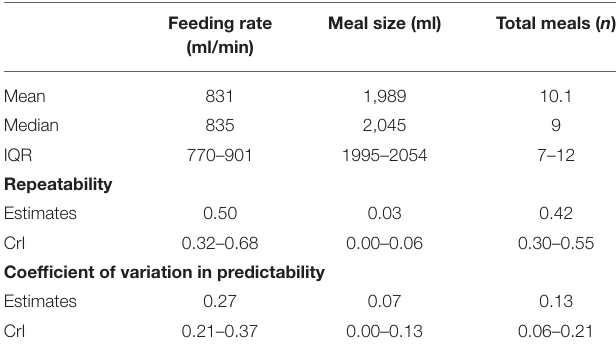
TABLE 3 | Mean, median, inter-quartile range, repeatability, and coefficient of variation in predictability for total meals, feeding rate, and meal size. Feeding rate Meal size (ml/min)